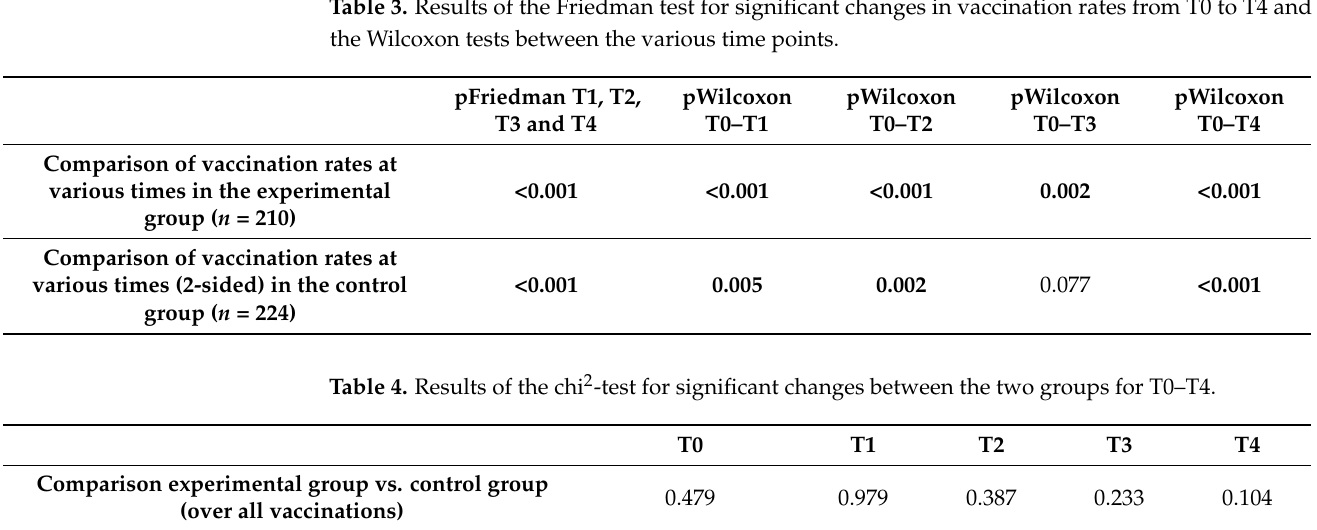
Comparison experimental group vs. control group